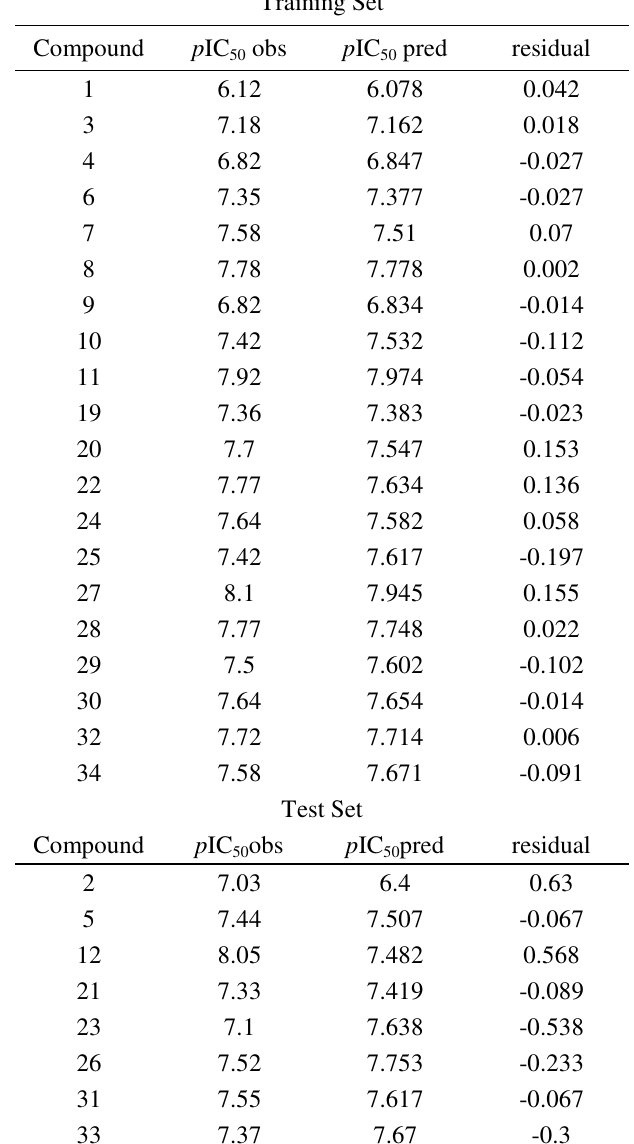
Table 2 . Observed and predicted activities of compounds used in training and test set Training